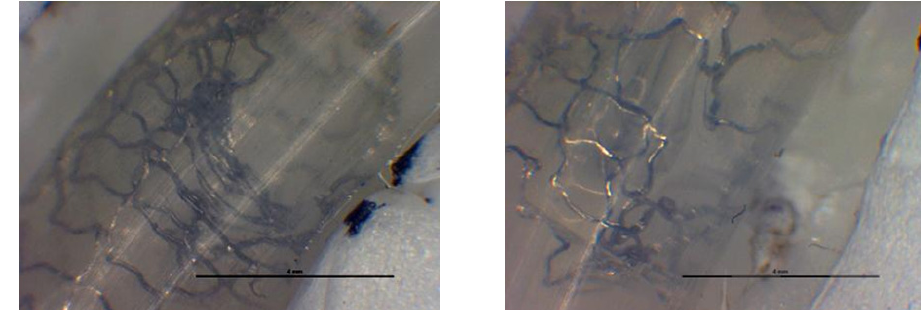
Figure 5: Liberté stent creased (left) and fractured (right)